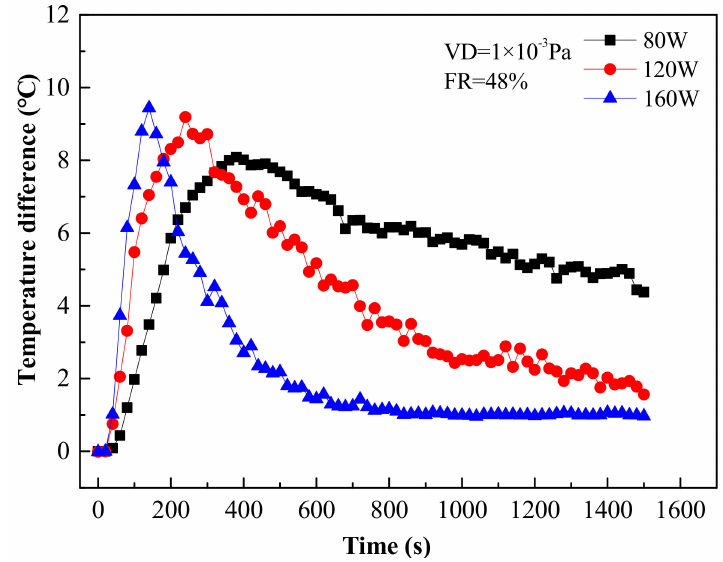
Figure 7. Temperature difference on the Z-axis of the PGHP changing with time under different heating power